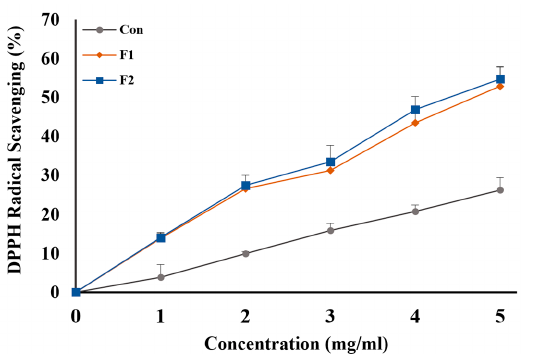
Figure 2. DPPH radical scavenging activity of AGN and HME-AGN extracts. Data are expressed as means ± standard deviation (n = 3).